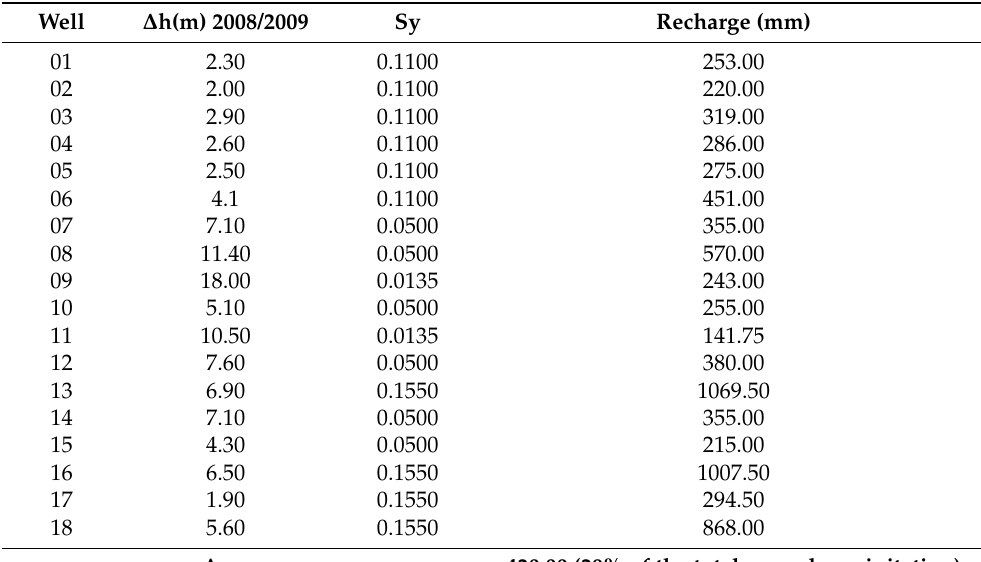
Table 5. Point recharge rate in the monitoring wells according to the water table elevation (WTE)